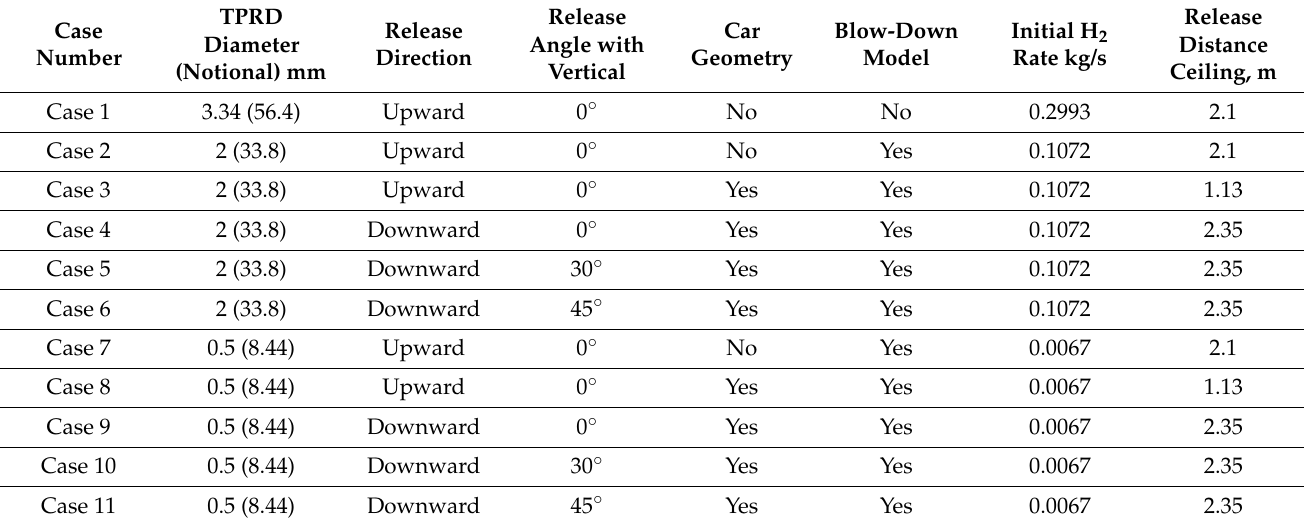
Table 1. Numerical experiments considered for a covered car park with natural